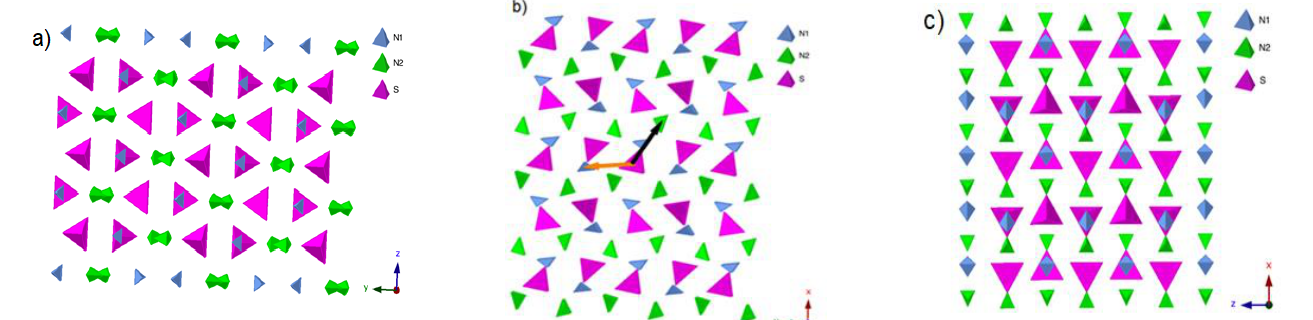
Figure 4. ( a ) (100) Projection with the y -axis horizontal; ( b ) (001) projection with the y -axis horizontal; ( c ) (010) projection with the z -axis horizontal. The polyhedral colors are: cyan for N1H 4 , green for N2H 4 , purple for SO 4 . The segments in Figure 4b represent, in black, the distance S-N1, inclined with the largest component oriented along the x axis; and, in orange, the distance S-N2 oriented along the y axis. Table 4. Sulfur-nitrogen distances (Å) at different pressures.